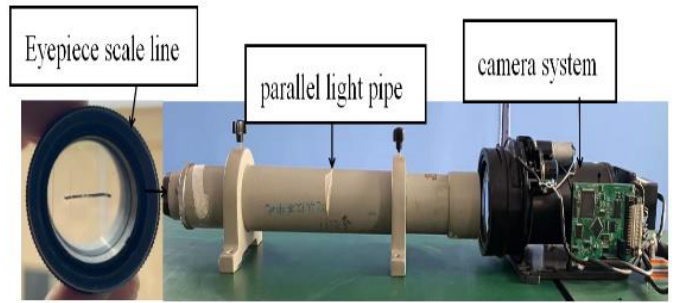
Figure 8. Measuring focal length physical figure.